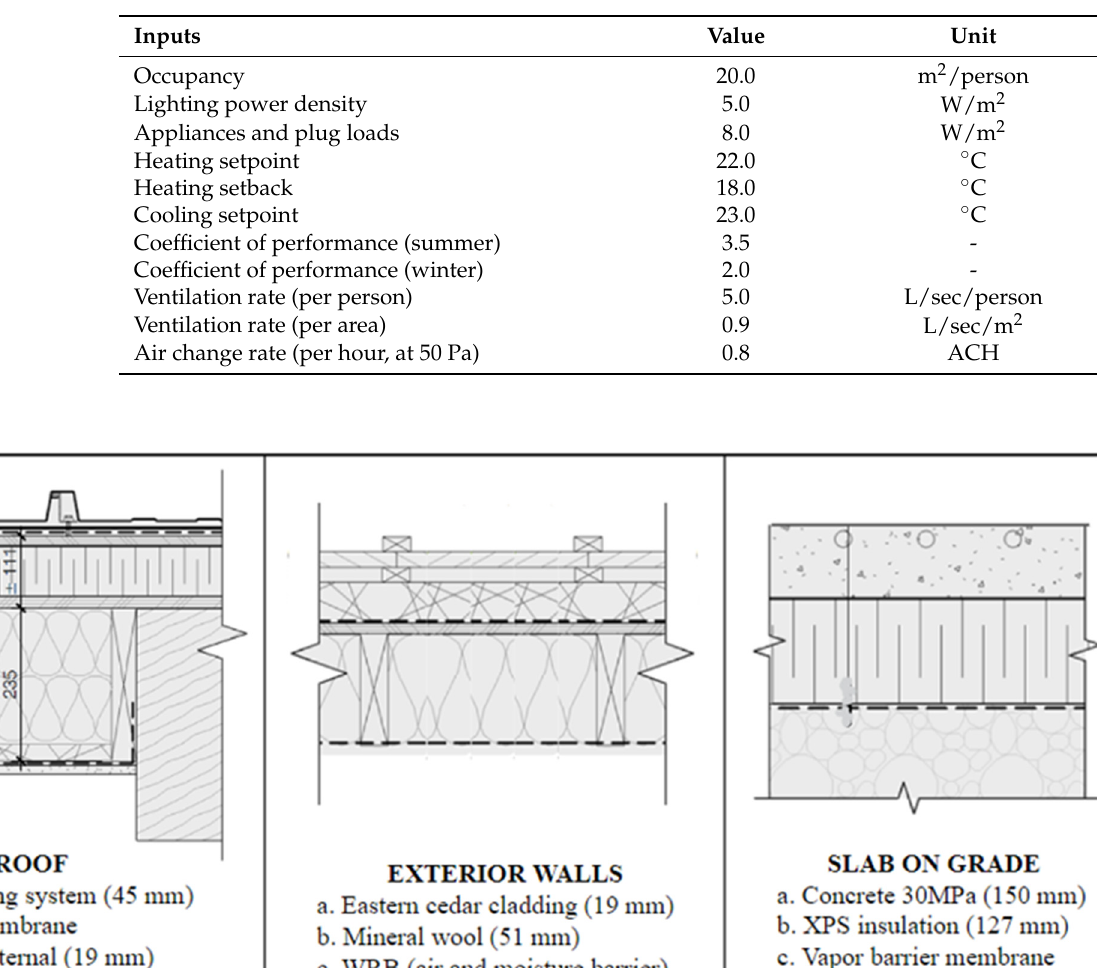
Table 3. Energy simulation inputs for FBL.